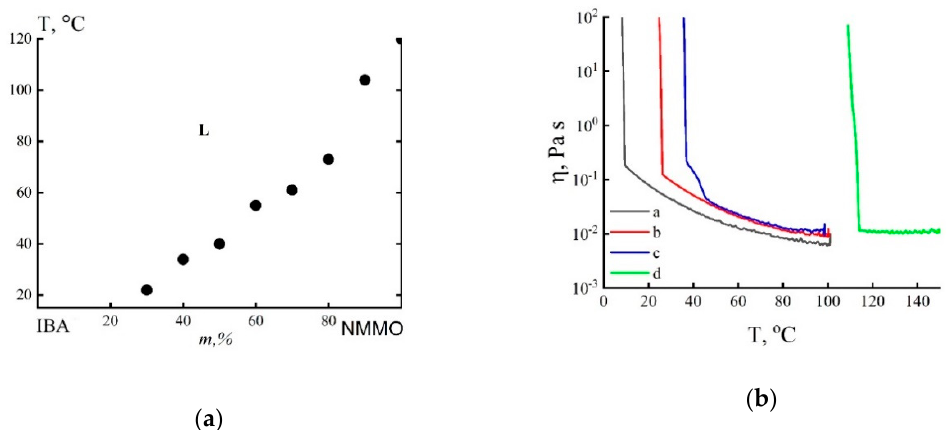
Figure 3. State diagram of the NMMO–isobutyl alcohol (IBA) system ( a ) and temperature dependences of viscosity ( b ) for the NMMO–IBA system with the ratio of components: 70/30 (a), 90/10 (b), 95/5 (c) and 100% NMMO (d).